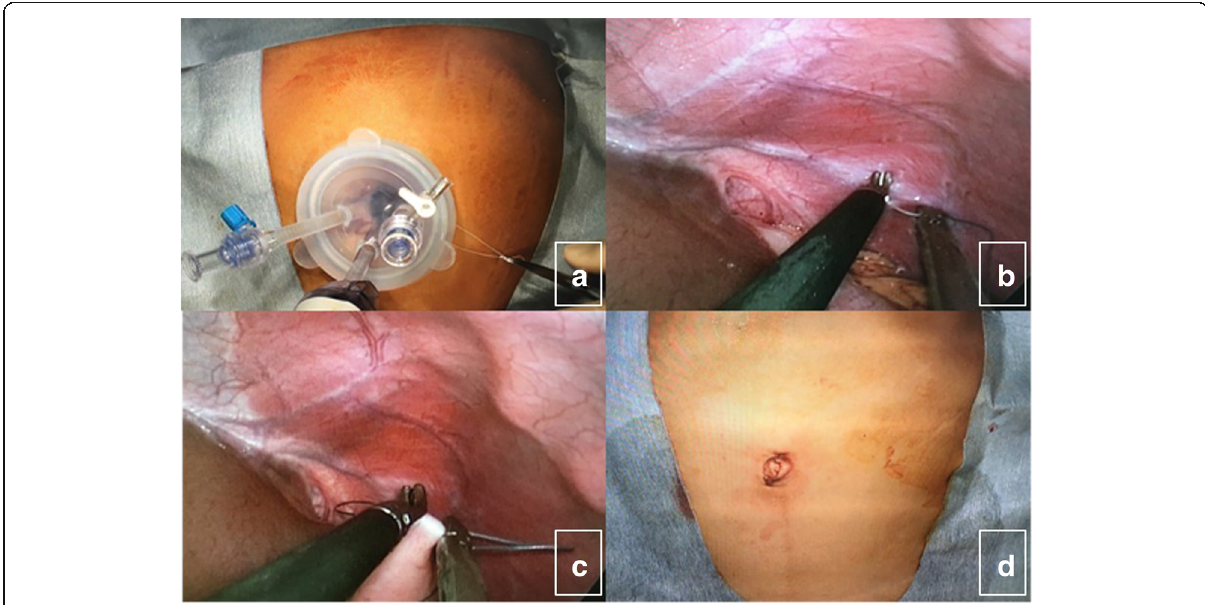
Fig. 1 The wound retractor (Lap Protector®, Hakko Medical, Japan) was inserted, and the silicon cap (EZ access®, Hakko Medical, Japan) was mounted to the retractor. Three 5-mm trocars (EZ trocar®, Hakko Medical, Japan) were placed in the cap ( a ). After creating a pneumoperitoneum of 6 – 10 mmHg, a 5-mm, 30° laparoscope was inserted into one of those trocars. Then, laparoscopic exploration confirmed the presence of the gastrosplenic ligaments in all three cases. The anterior wall of the body of the stomach was sutured to the peritoneum using 3-0 non-absorbable sutures ( b , c ). The first suture was made on the fundus to the diaphragm. The other five sutures were made along the major curve of the stomach. We tried not to create the big space between the sutures for prevention of occurrence of an internal hernia. The scar was very